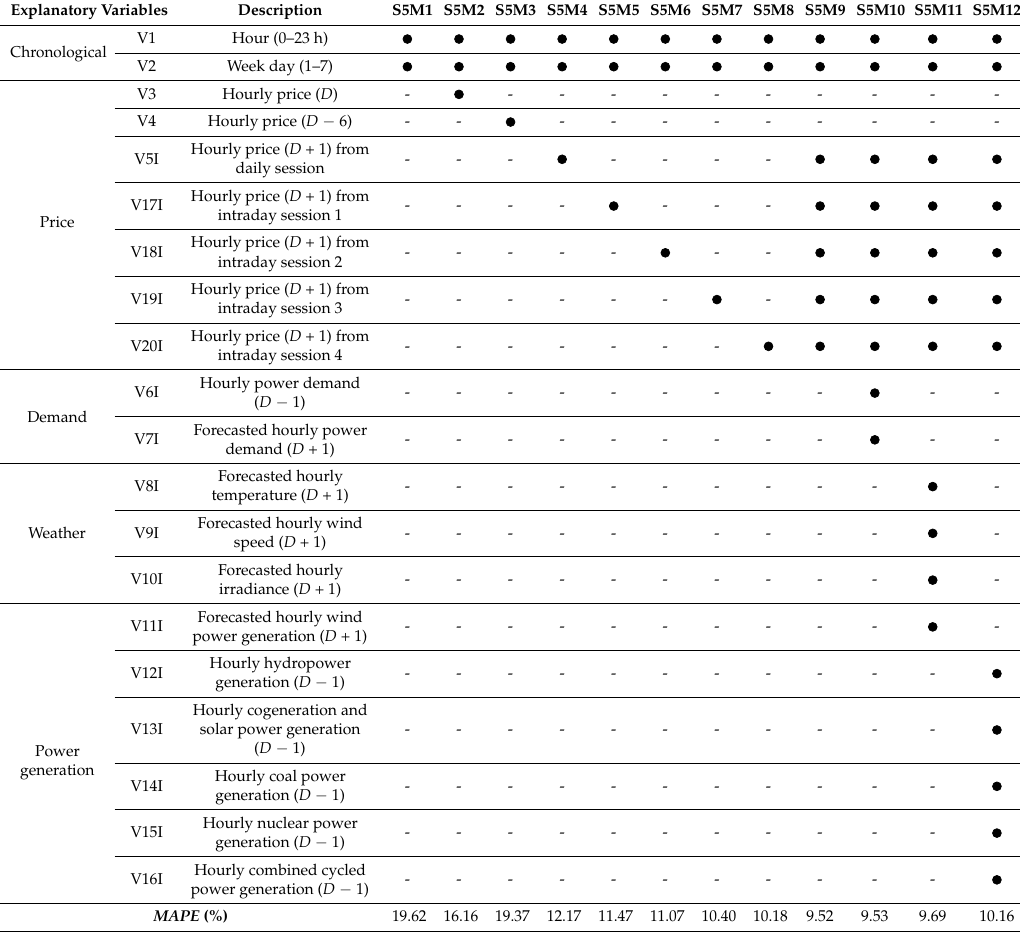
Table 12. ISMPF models for intraday session 5 and their MAPEs